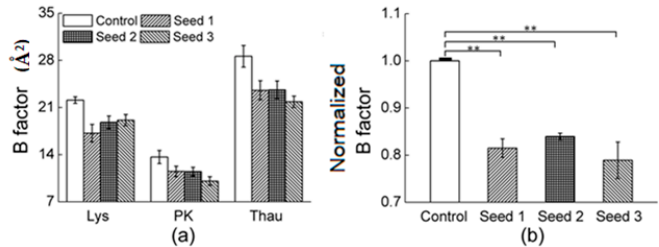
Figure 4. One-way ANOVA analysis on the B-factor, the error bars show the standard error of the mean. ( a ) A comparison of the B-factors of protein crystals obtained in the presence and absence of CLPC seeds, ( b ). Averaged normalized B-factor values in the presence and absence of CLPC seeds. ( ** represents saliency). In terms of the protein crystals, the results showed that there were significant differences between the control group and other groups. (n = 3, P < 0.05). Crystals with seeds showed a better B-factor values.